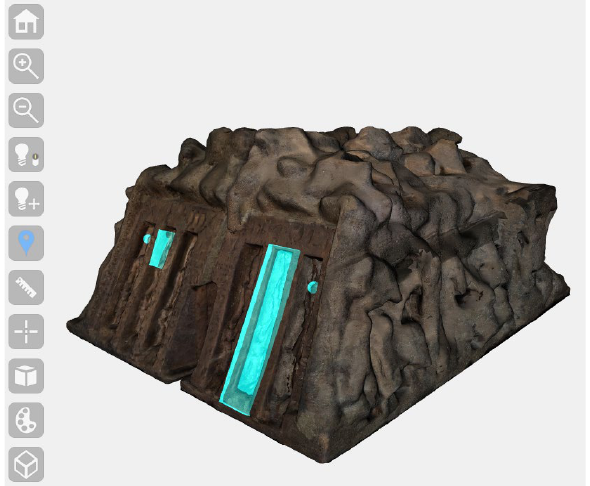
Figure 13. Hotspots layer on the web-portal